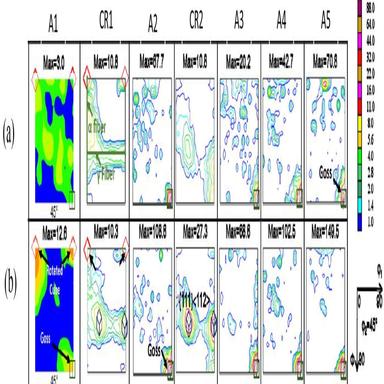
Texture evolution during the thermo-mechanical processing obtained by EBSD (A1) and by X-Ray diffraction of samples (a) HR1 and (b) HR6.